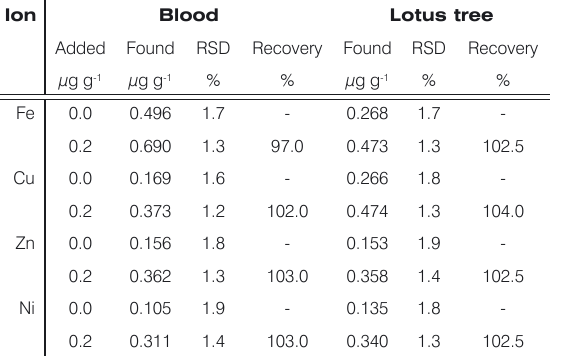
Table 3. Recovery of trace elements from spiked environmental samples after application of presented procedure Ion Added, Found, RSD, Recovery, µg mL -1 µg mL -1 % % BCR 185 R liver certified reference material ( mg kg -1 ) a Fe